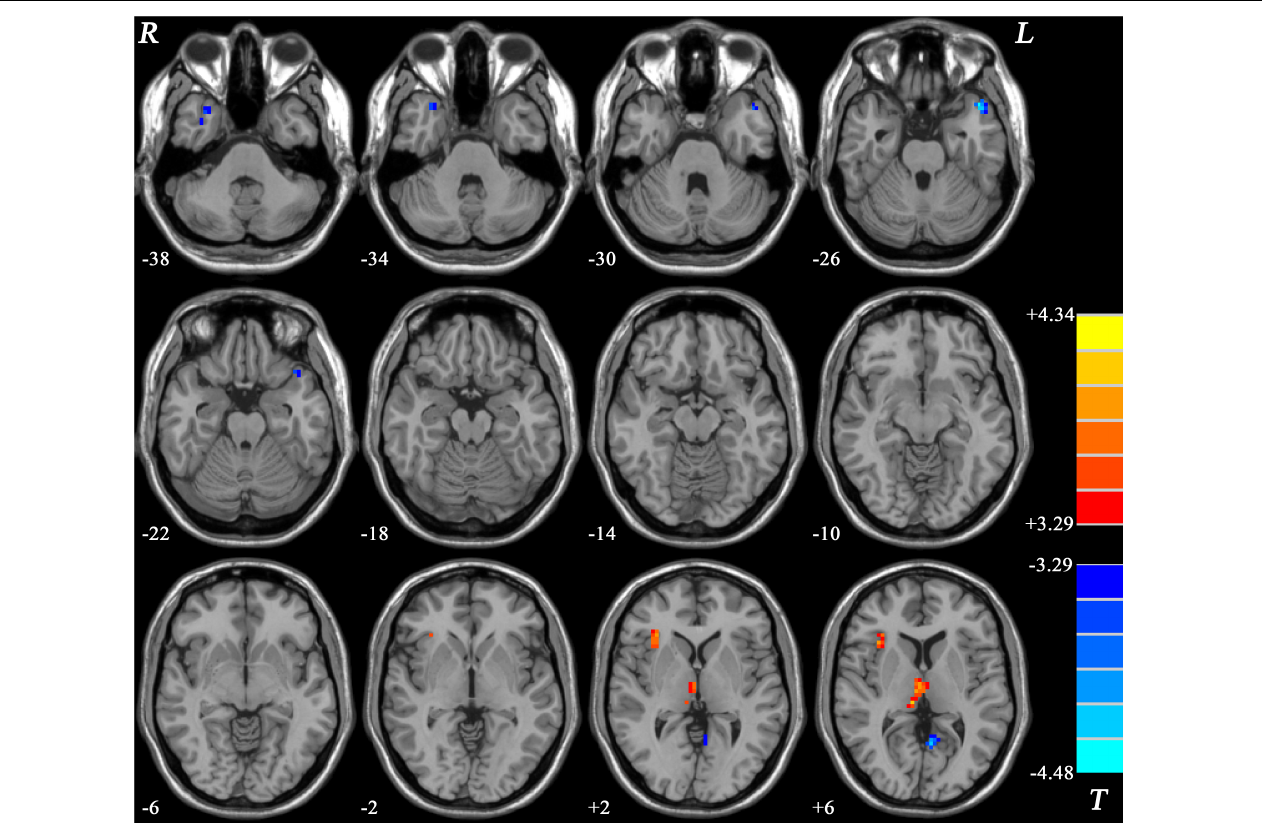
FIGURE 3 | Statistical map depicts higher and lower GFC of MDD patients with GI symptoms compared with healthy controls. Blue denotes lower GFC and red denotes higher GFC. Color bar indicates T values from two-sample t -test. MDD, major depressive disorder; GFC, global functional connectivity; GI, gastrointestinal